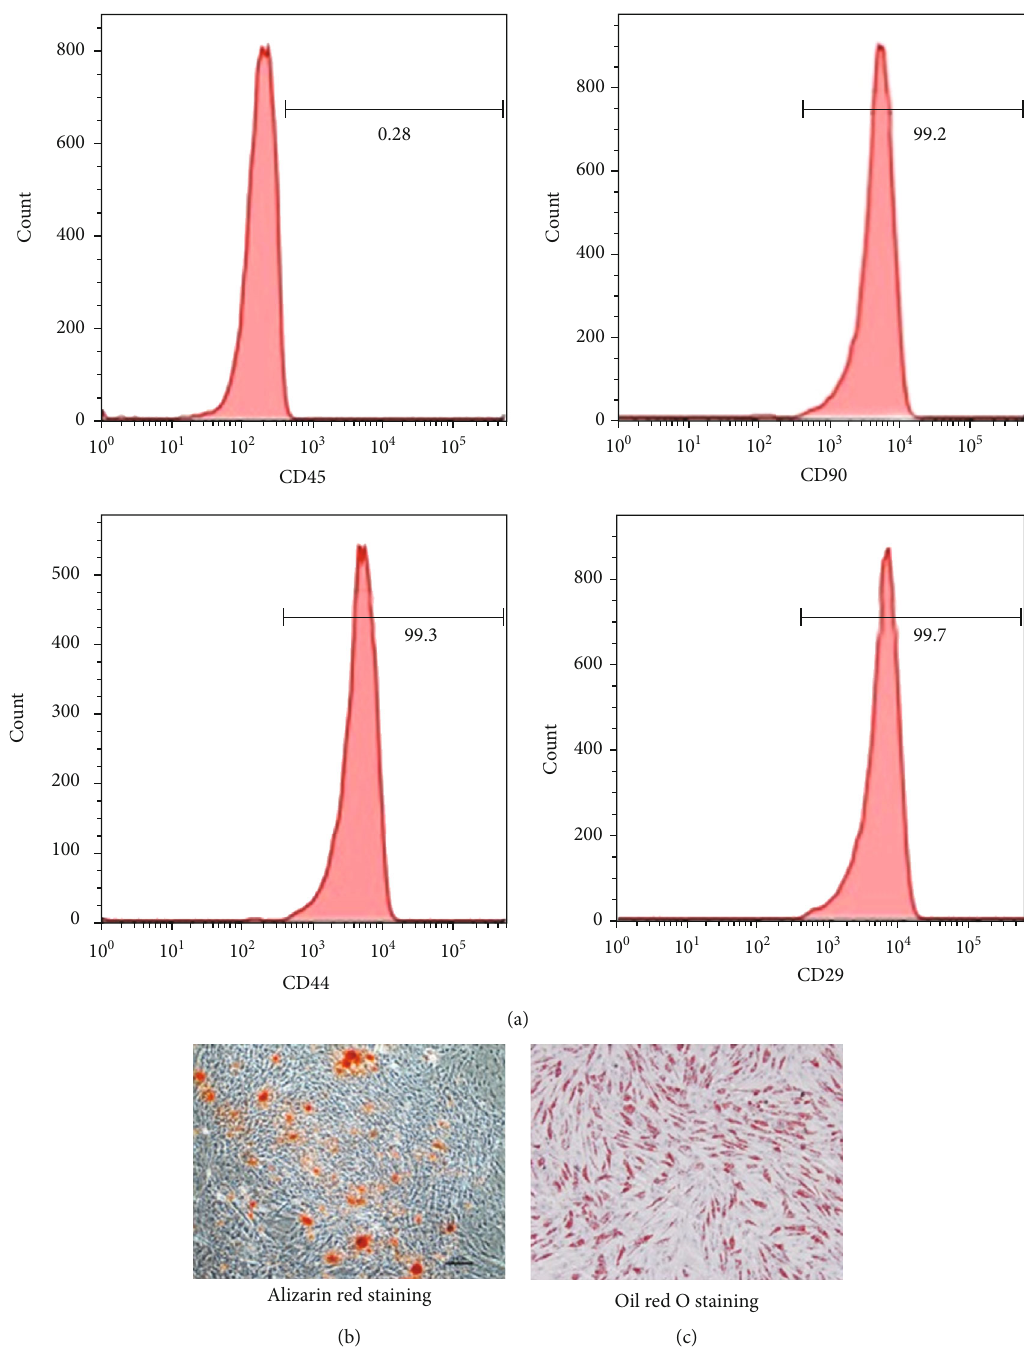
Figure 3: Characterization of ASCs by surface marker phenotype and di ff erentiation potential. ASCs were assessed for the presence of mesenchymal stem cell properties. (a) Immunophenotype assessment of ASCs via fl ow cytometry analysis of the percentage of positive mesenchymal stem cell markers (CD90, CD44, and CD29) and negative hematopoietic markers (CD45). (b) Osteogenic-di ff erentiated cells were analyzed by Alizarin red staining. (c) Adipogenic-di ff erentiated cells were analyzed by oil red O